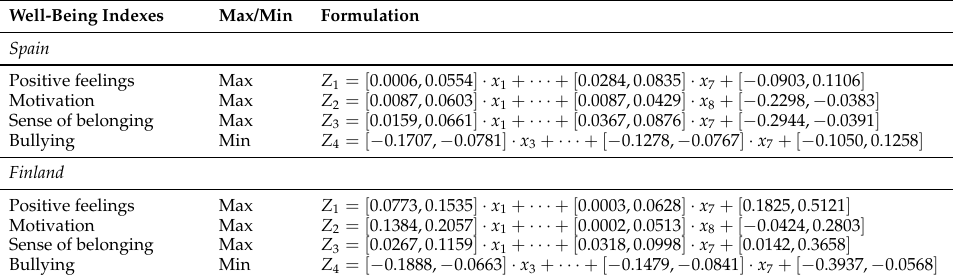
Table 5. Linear interval objective functions for Spain and Finland.